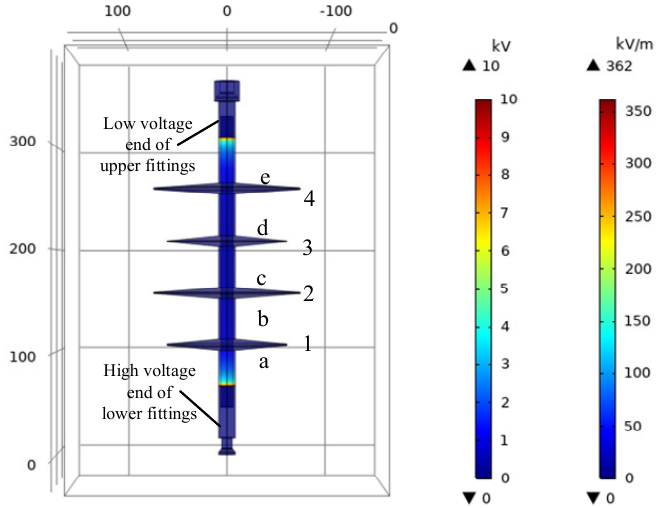
Figure 1. Electric field potential distribution of the normal composite insulator.